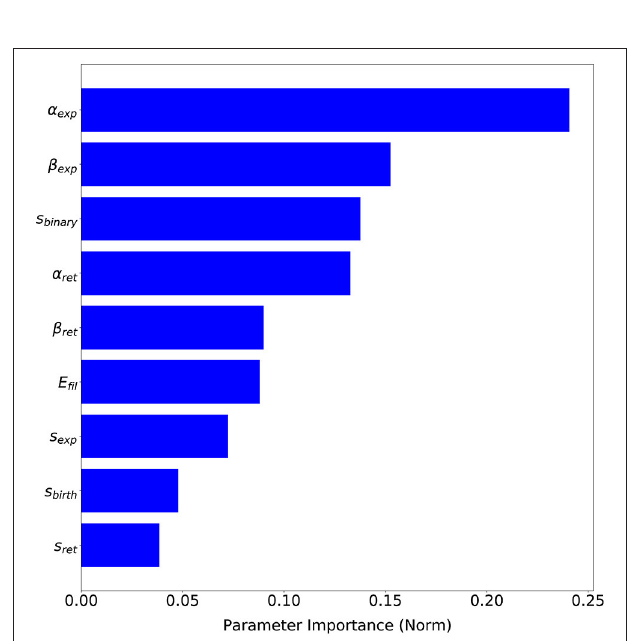
FIGURE 8 | Values associated to both metrics ( BC llp and BC np ) for the 300 model parametrizations suggested by SigOpt during the calibration process. Red circles are associated to every parametrization tested whereas the blue ones represent Pareto optimal points (parametrizations where one metric cannot be improved without another metric suffering) and form an approximate Pareto frontier.